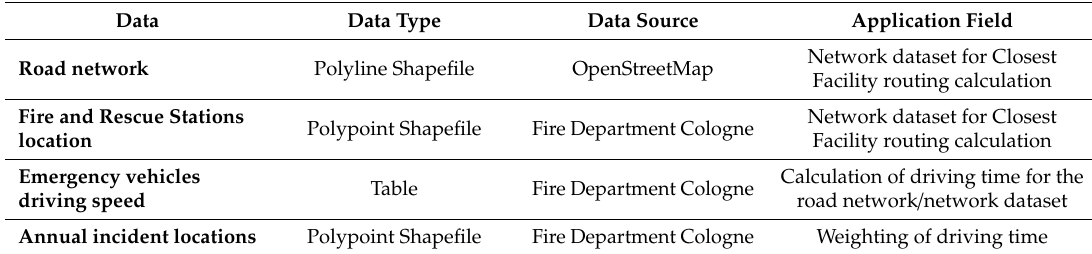
Table 2. Input data for model construction and calculation.